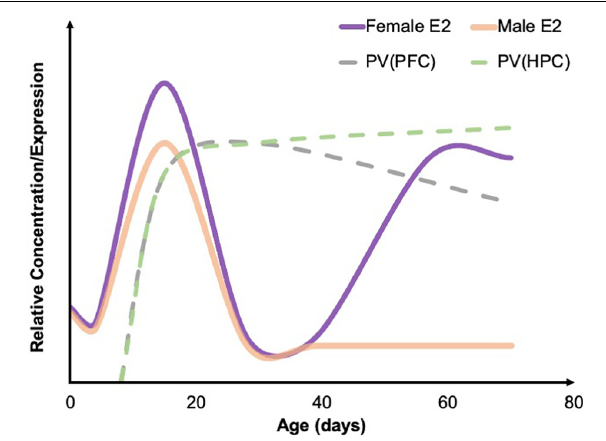
FIGURE 1 | Developmental trajectories of estradiol and PV. A summary of the developmental trajectory of estradiol (E2) concentrations in male (solid orange) and female (solid purple) rodents across early postnatal development through young adulthood, as well as the general developmental trajectory of PV levels in the PFC (dashed gray) and HPC (dashed green). Both males and females see a spike in E2 around P15. PV concentrations across development have not been well studied; however, existing developmental work suggests that PV levels in the HPC steadily increase through early adulthood, while PV levels remain relatively stable in the PFC. Figure adapted from data presented in Bell (2018), de Lecea et al. (1995), and Du et al. (2018). PFC, prefrontal cortex; HPC, hippocampus; PV,